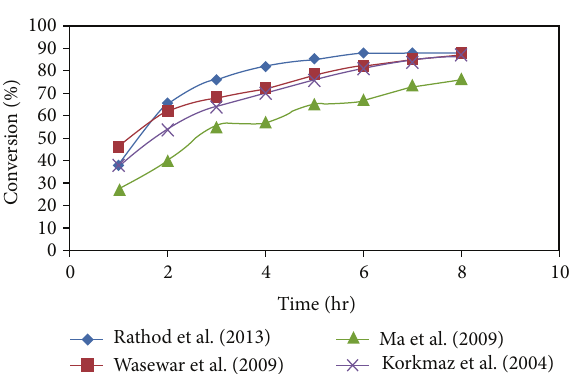
Figure 7: Different trends of conversion of acid with time for esterification without pervaporation system.